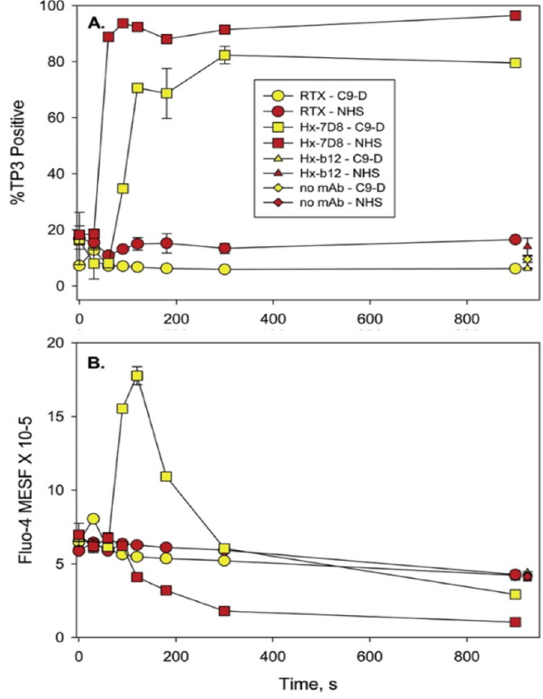
Figure 15. Analysis of CDC and Ca 2 + fluxes in Fluo-4-loaded CLL cells. ( A ) CDC kinetics mediated by Hx-7D8 in C9-D serum (pn 2014, red circles, Figure 14) were slower and killing peaked at approximately